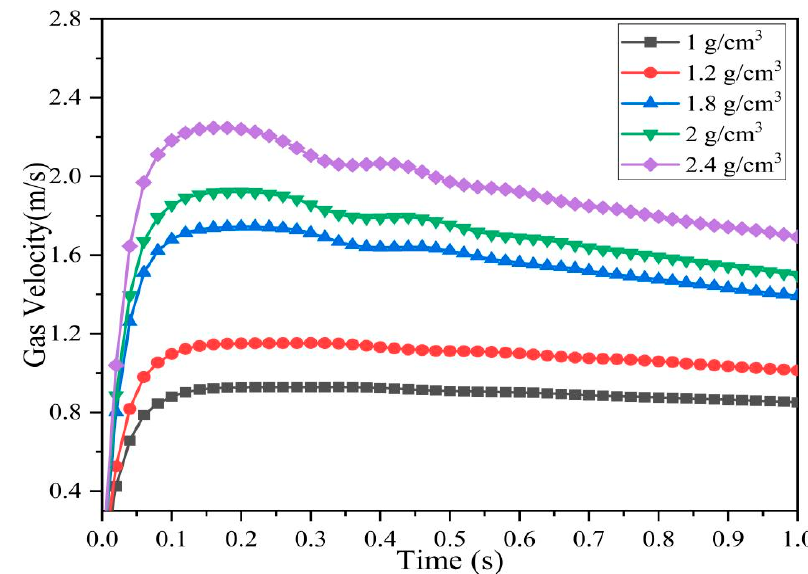
Figure 8. Velocity of a point in the fracture under different drilling fluid densities.